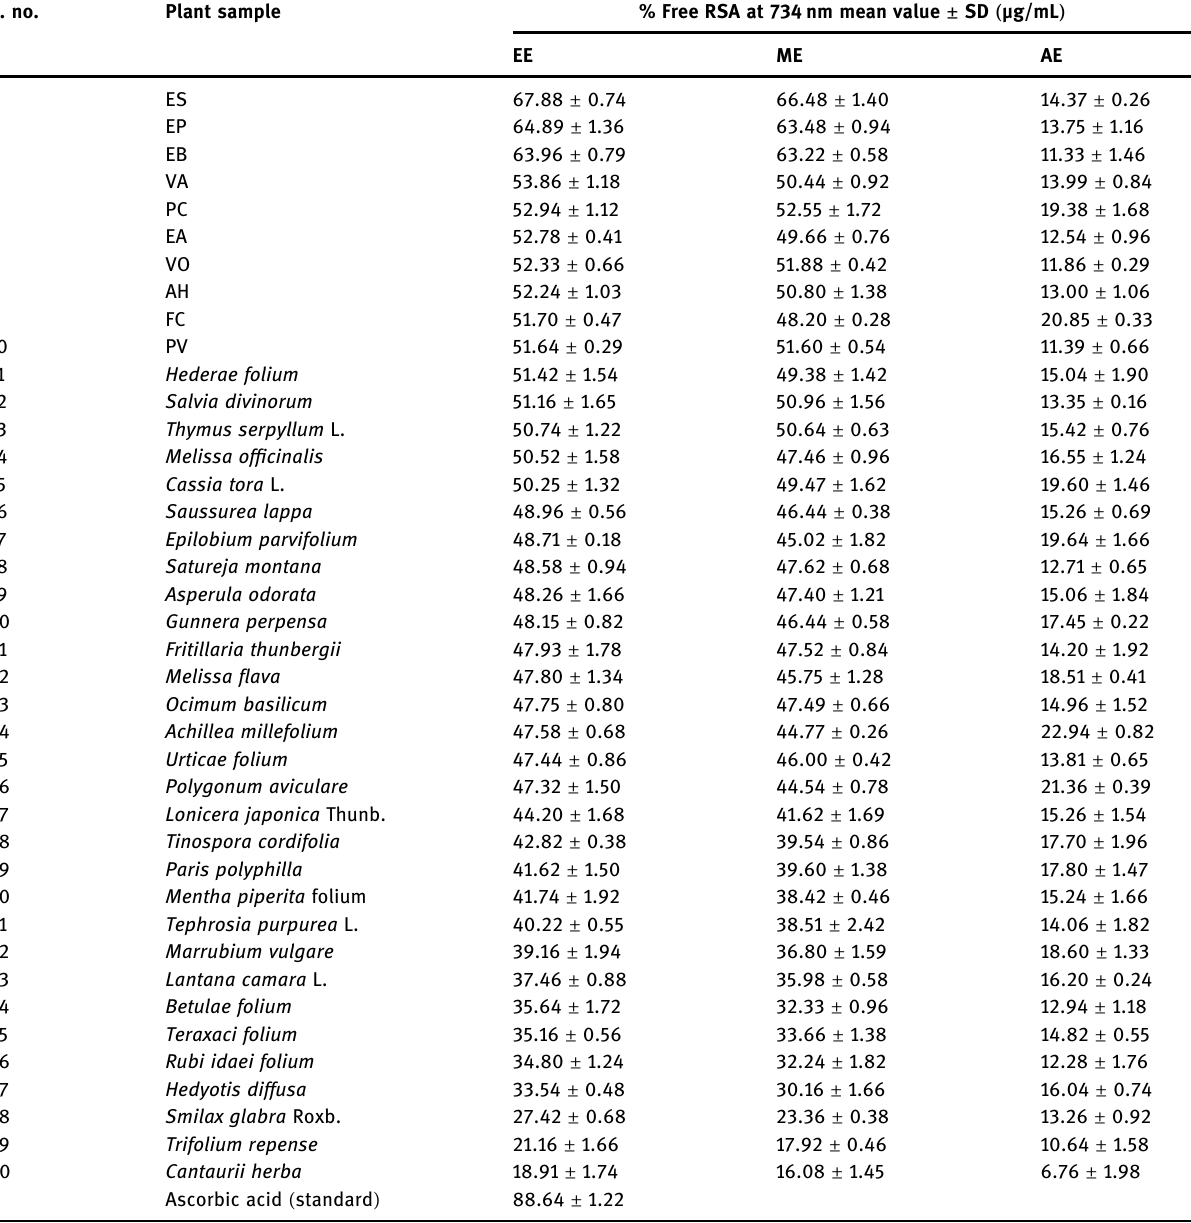
Table 7: The inhibitory e ff ects of various medicinal plant extracts in ABTS assay at 734 nm S.